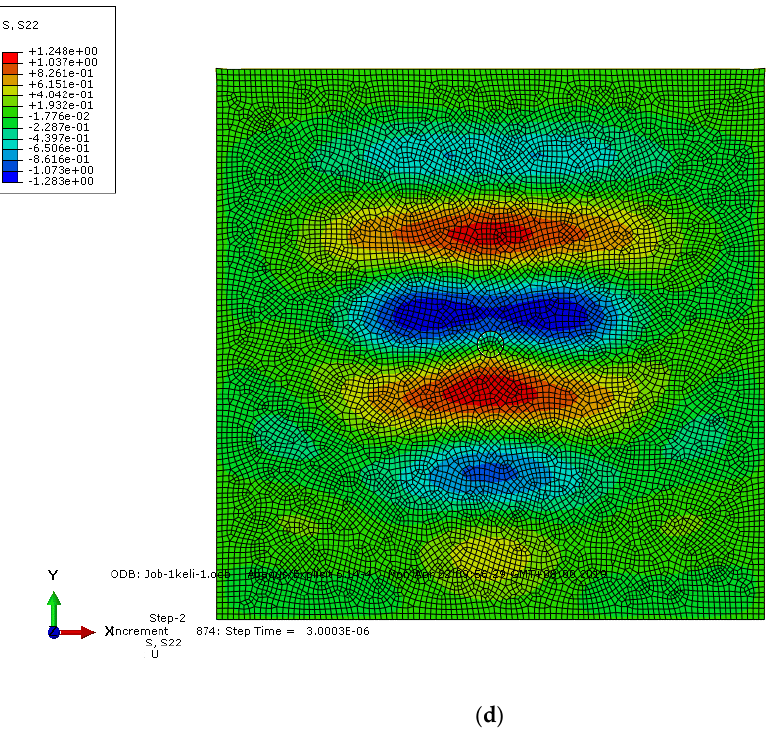
Figure 11. Cloud diagram of the 1 MHz ultrasonic propagation process in a single-particle RVE model after ( a ) 1.2531, ( b ) 2.2534, ( c ) 3.5012, and ( d ) 8.0003 µ s. Table 4. Ultrasonic attenuation coefficients of the two representative volume unit (RVE) models. RVE Model Ultrasonic Frequency (MHz) Single Particle Estane Binder Difference